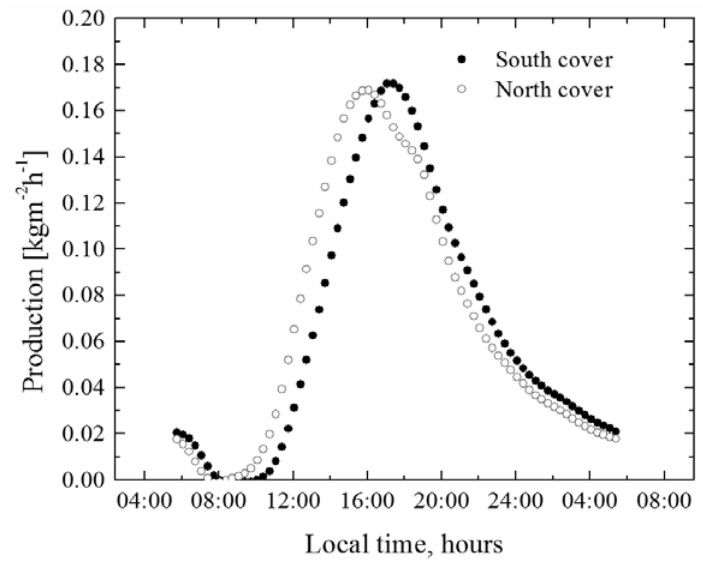
Figure 12. Distillate production with condensers facing a north-south direction in a double-slope condenser solar still (Reprinted from [19], with permission from Elsevier, 2019).